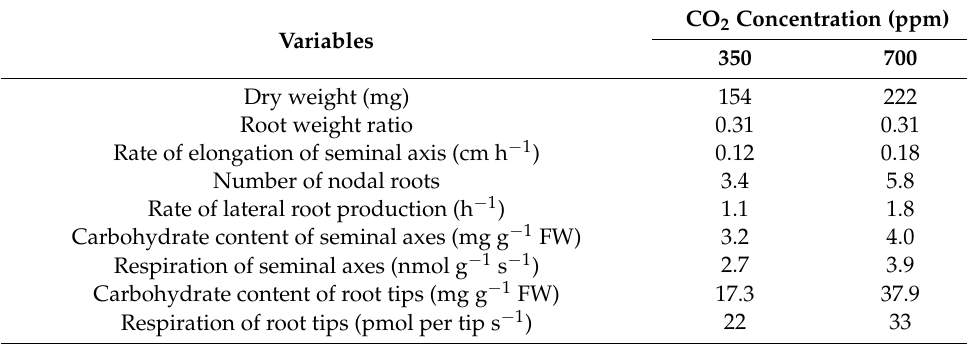
Table 2. Growth and root metabolism of barley at 14 days after germination under two CO 2 concen- trations (Source: Farrar and Jones